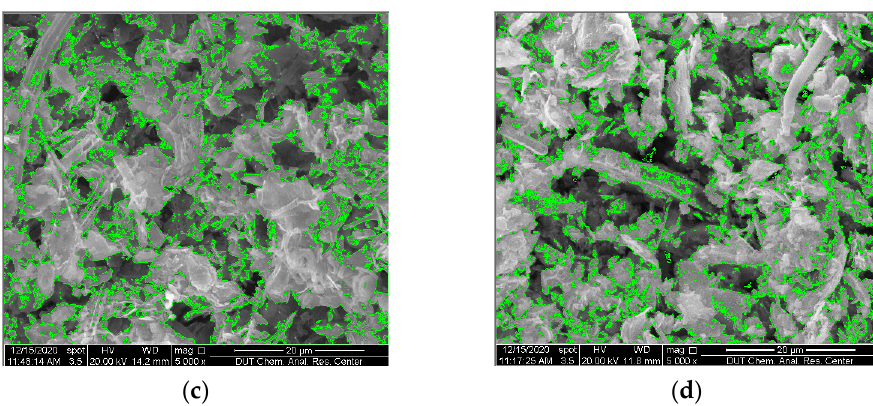
Figure 8. SEM images of the five sediment segments at 20 °C and 4 °C (pores of sediment segments represented by the green outlines): ( a ) S1 at 20 °C; ( b ) S1 at 4 °C; ( c ) S2 at 20 °C; and ( d ) S2 at 4 °C.